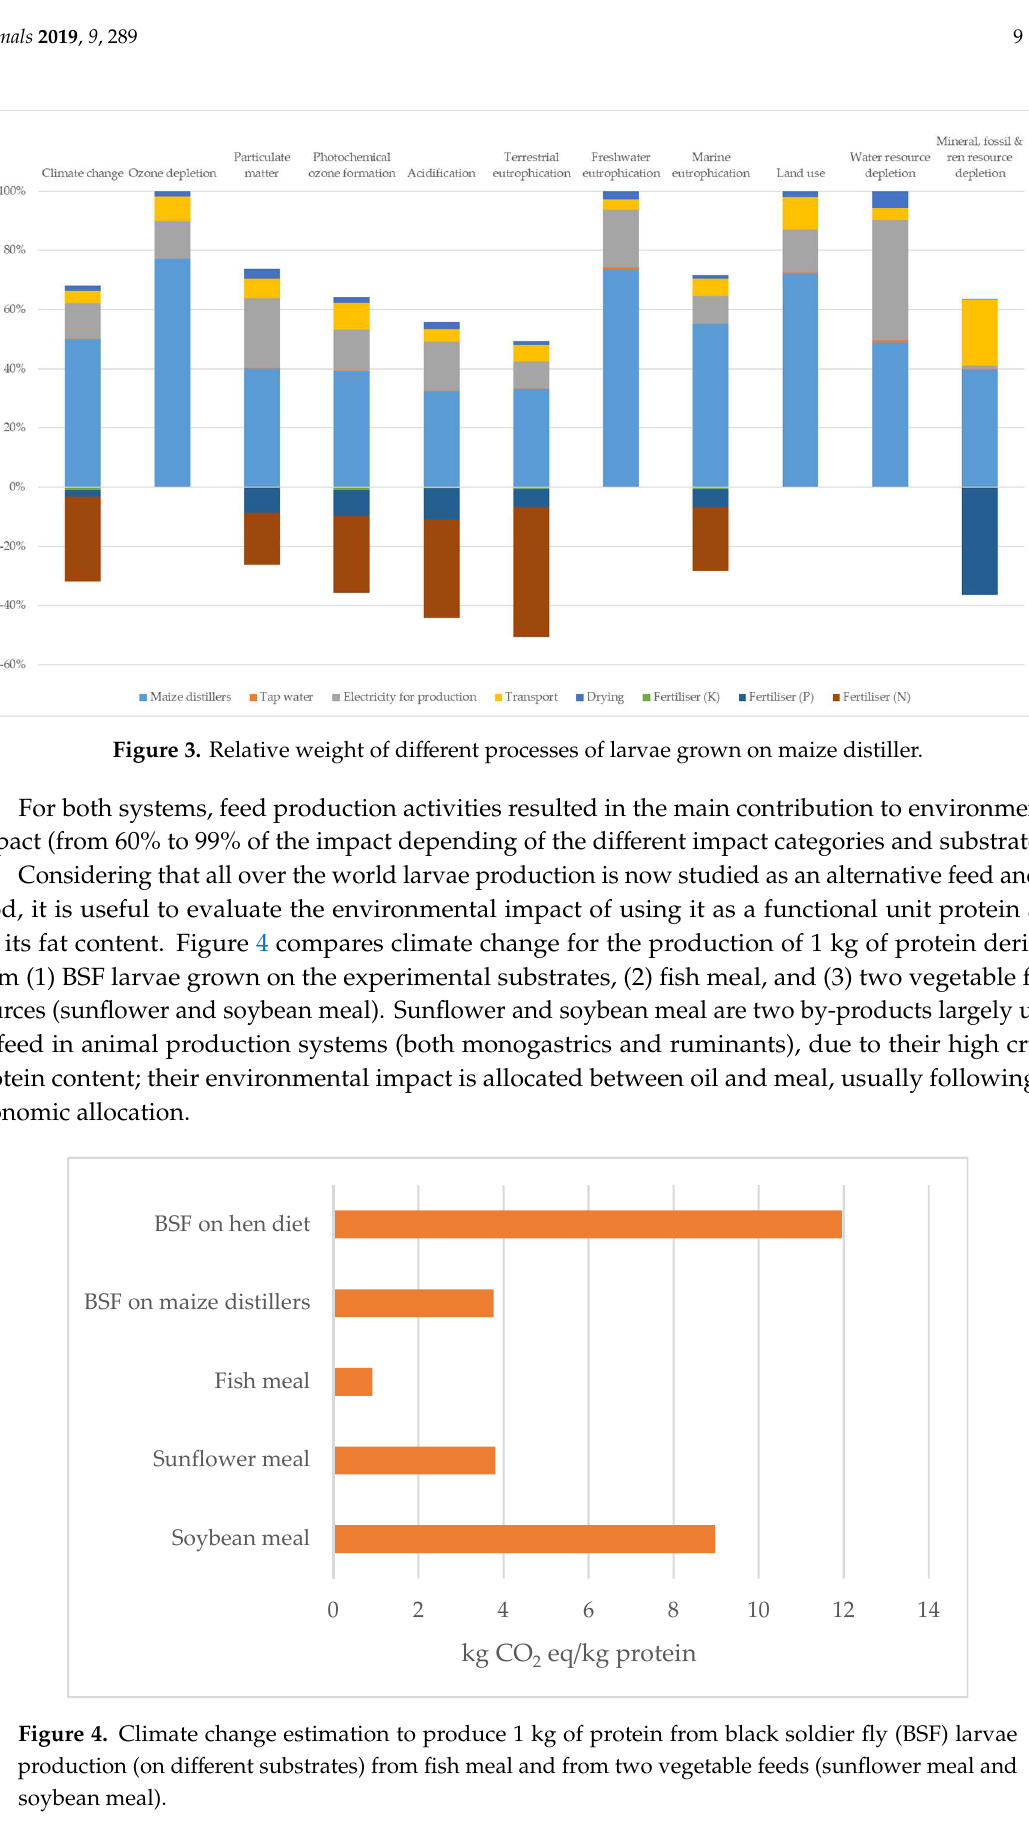
Figure 2. Relative weight of different processes of larvae grown on a hen diet.